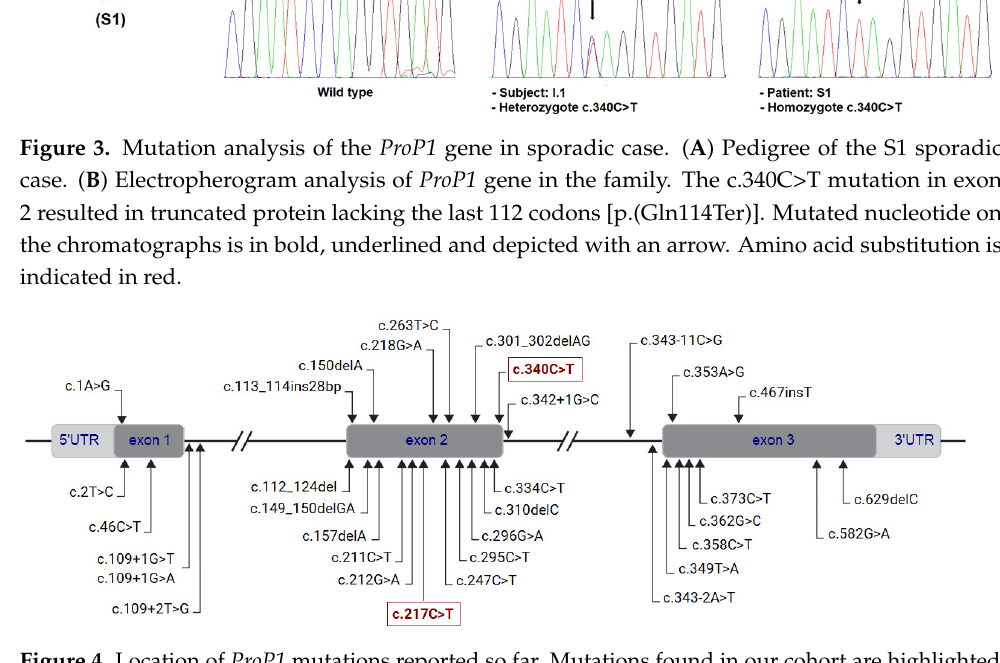
Figure 4. Location of ProP1 mutations reported so far. Mutations found in our cohort are highlighted. Exons are represented by shaded boxes. Exons, introns, and untranslated regions (5’ and 3’UTRs) are not drawn to scale.